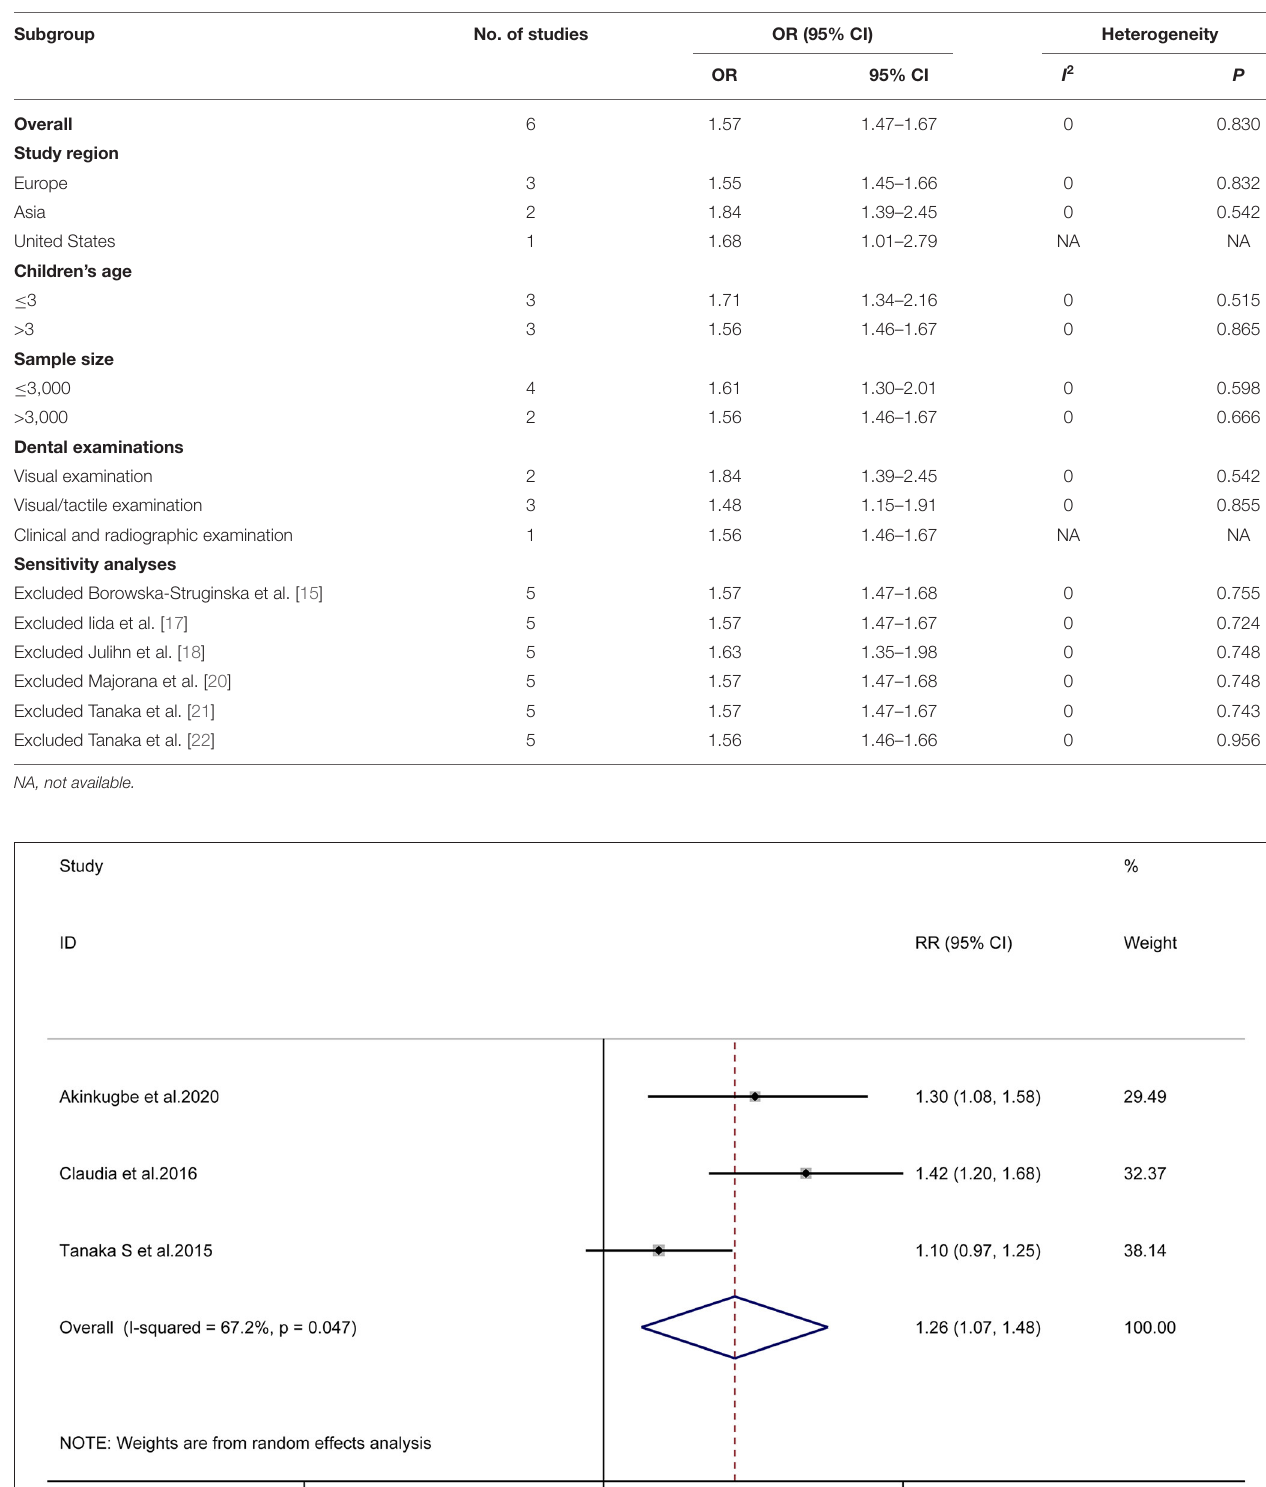
TABLE 3 | The results of subgroup and sensitivity analyses.